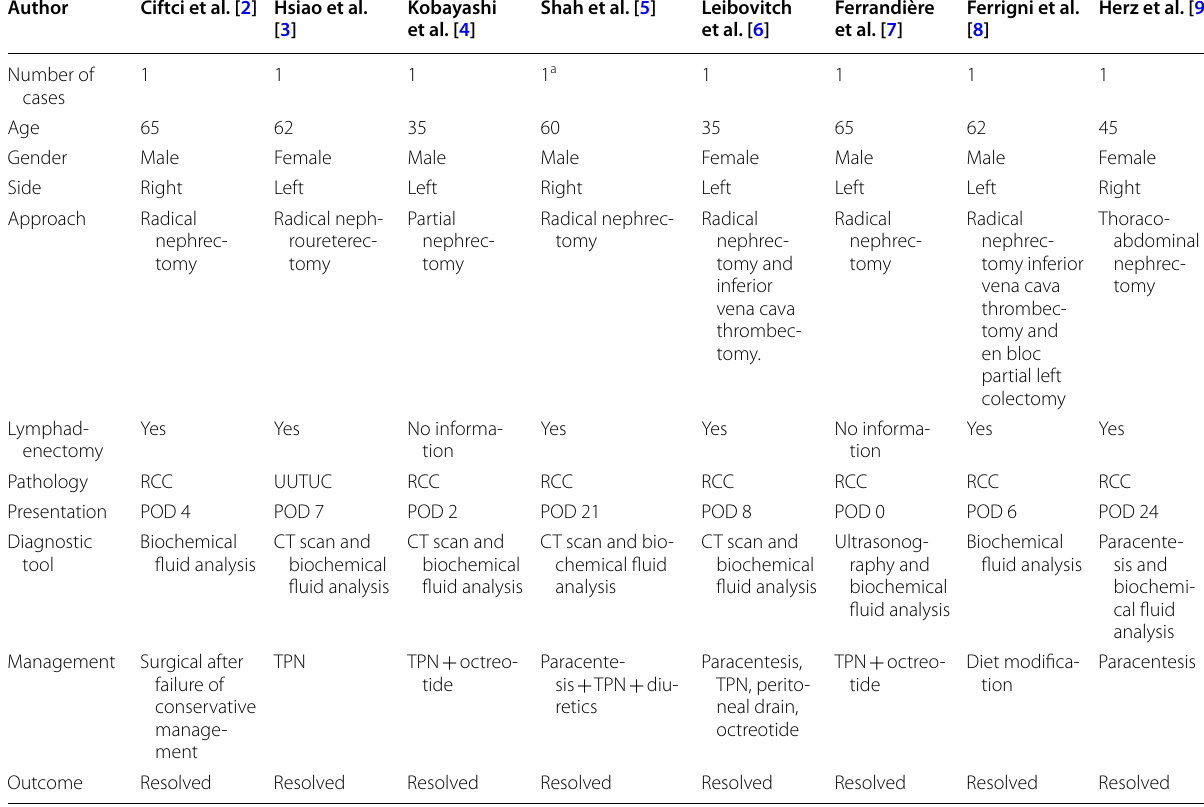
Table 1 Summary of literature review of chylous ascites after open nephrectomy/nephroureterectomy for adult patient with